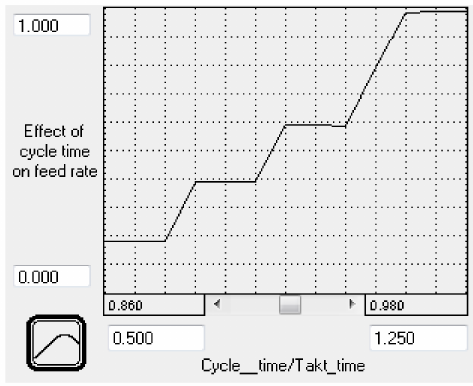
Figure 7. Behavior of the effect of cycle time on feed